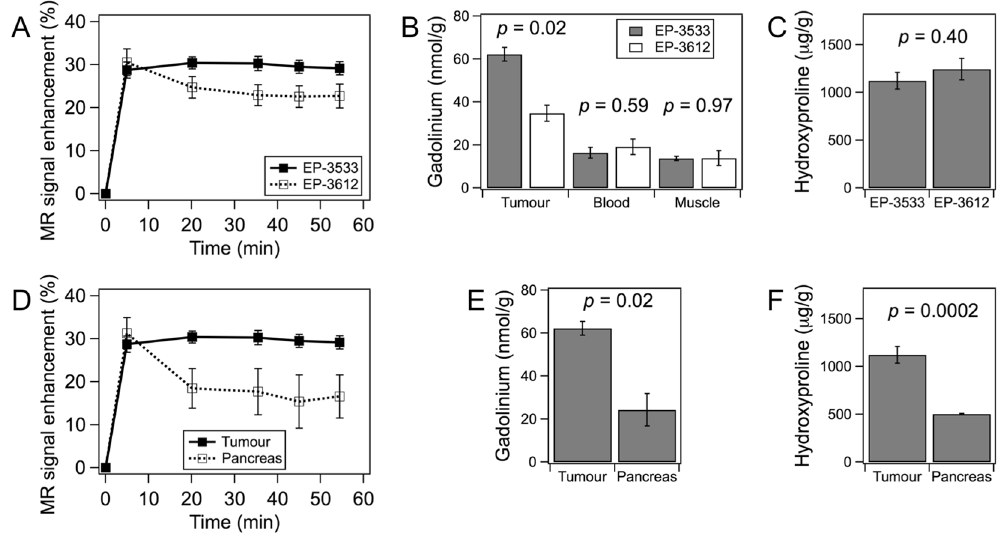
Figure 4. Dynamic contrast enhancement of tumours and pancreas with EP-3533 and EP-3612, Gd biodistribution and tissue hydroxyproline content in PDAC tumours and adjacent tissue. ( A ) Average MR signal enhancement relative to baseline (time = 0 min) in well-perfused tumour regions with EP-3533 (filled symbols, n = 8) and EP-3612 (open symbols, n = 7). ( B ) Ex-vivo quantification of gadolinium at 80 min post- injection shows significantly higher uptake of collagen-targeted (n = 3) probe in tumour tissue compared to control probe (n = 2), but no difference in the reference blood and muscle tissue. ( C ) Hydroxyproline content in tumour tissues imaged with EP-3533 (n = 8) or EP-3612 (n = 7). ( D ) Average MR signal enhancement relative to baseline (time = 0 min) in well-perfused tissue regions obtained with EP-3533 in tumour (n = 8) and healthy pancreas (n = 3). ( E ) Ex-vivo quantification of gadolinium in tumour (n = 3) or healthy pancreas (n = 3) 80 min after EP-3533 injection. ( F ) Hydroxyproline content in tumour (n = 8) and healthy pancreas (n = 3) of mice imaged with